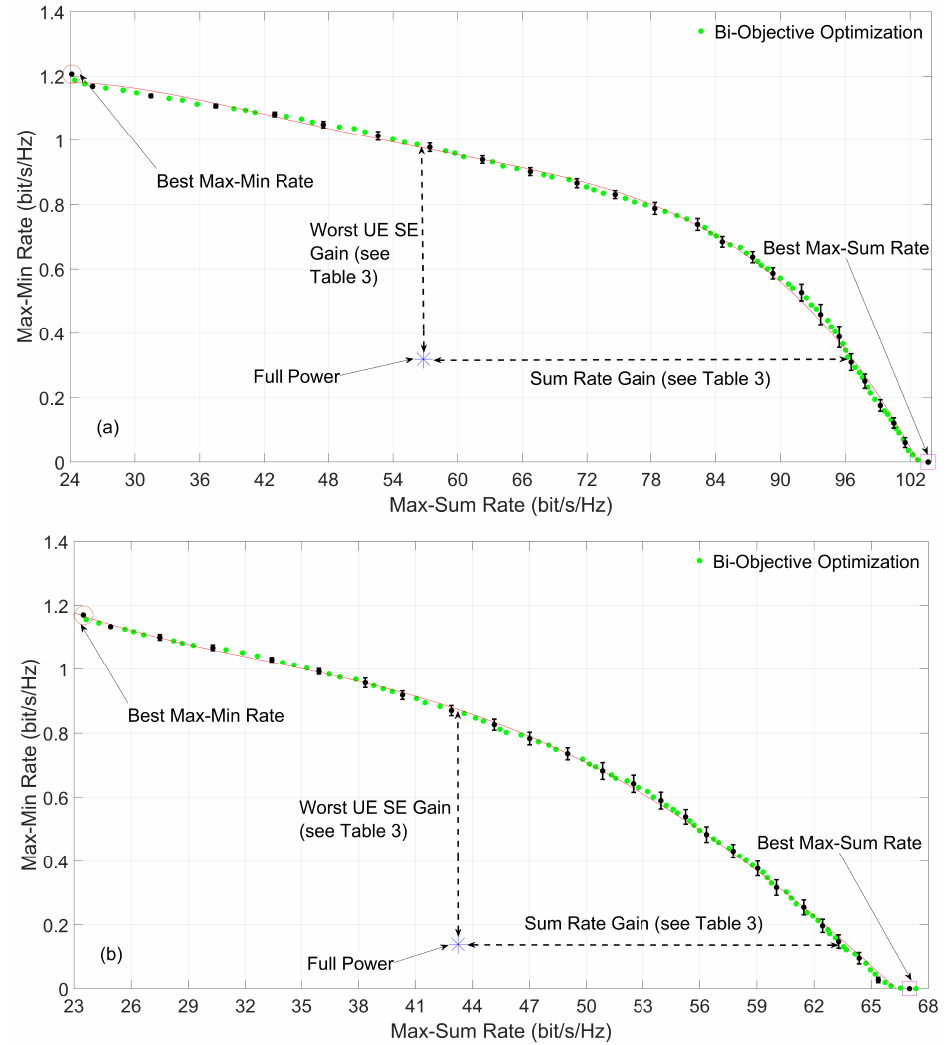
Figure 2. Bi-objective power optimization, max–min fairness and max–sum rate OF in a high UE density RS network with ( a ) high and ( b ) low maximum power.